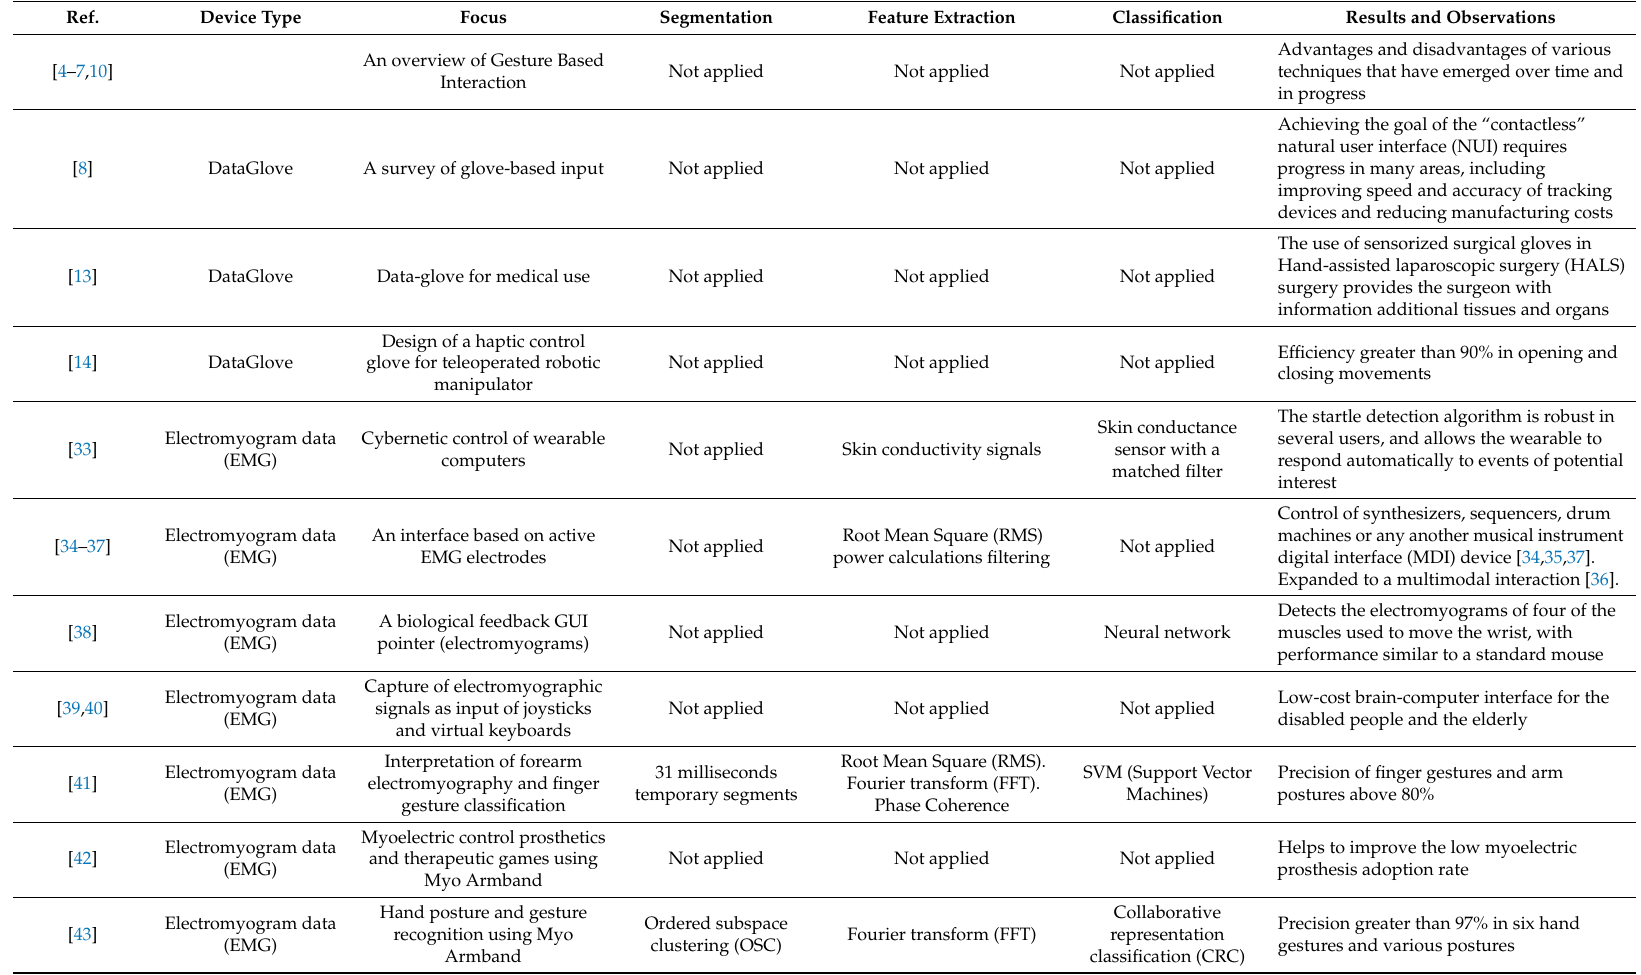
Table A2. Devices that work to recognize static and dynamic